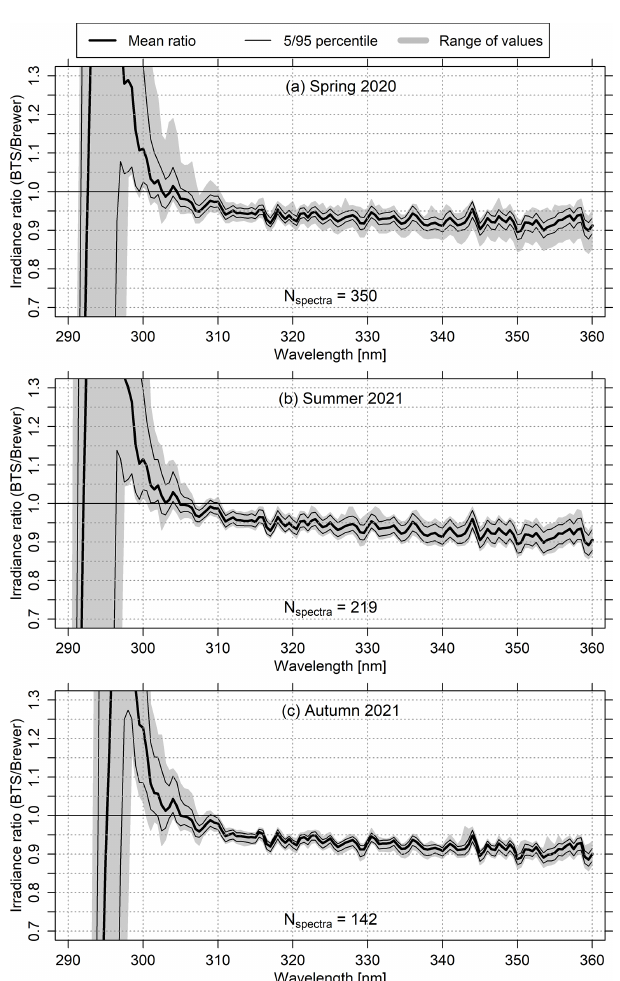
Figure 1. Average ratios, range of values and 5th and 95th per- centiles of global UV spectral measurements, from cloud-free con- ditions, between the BTS and the Brewer #150 during (a)